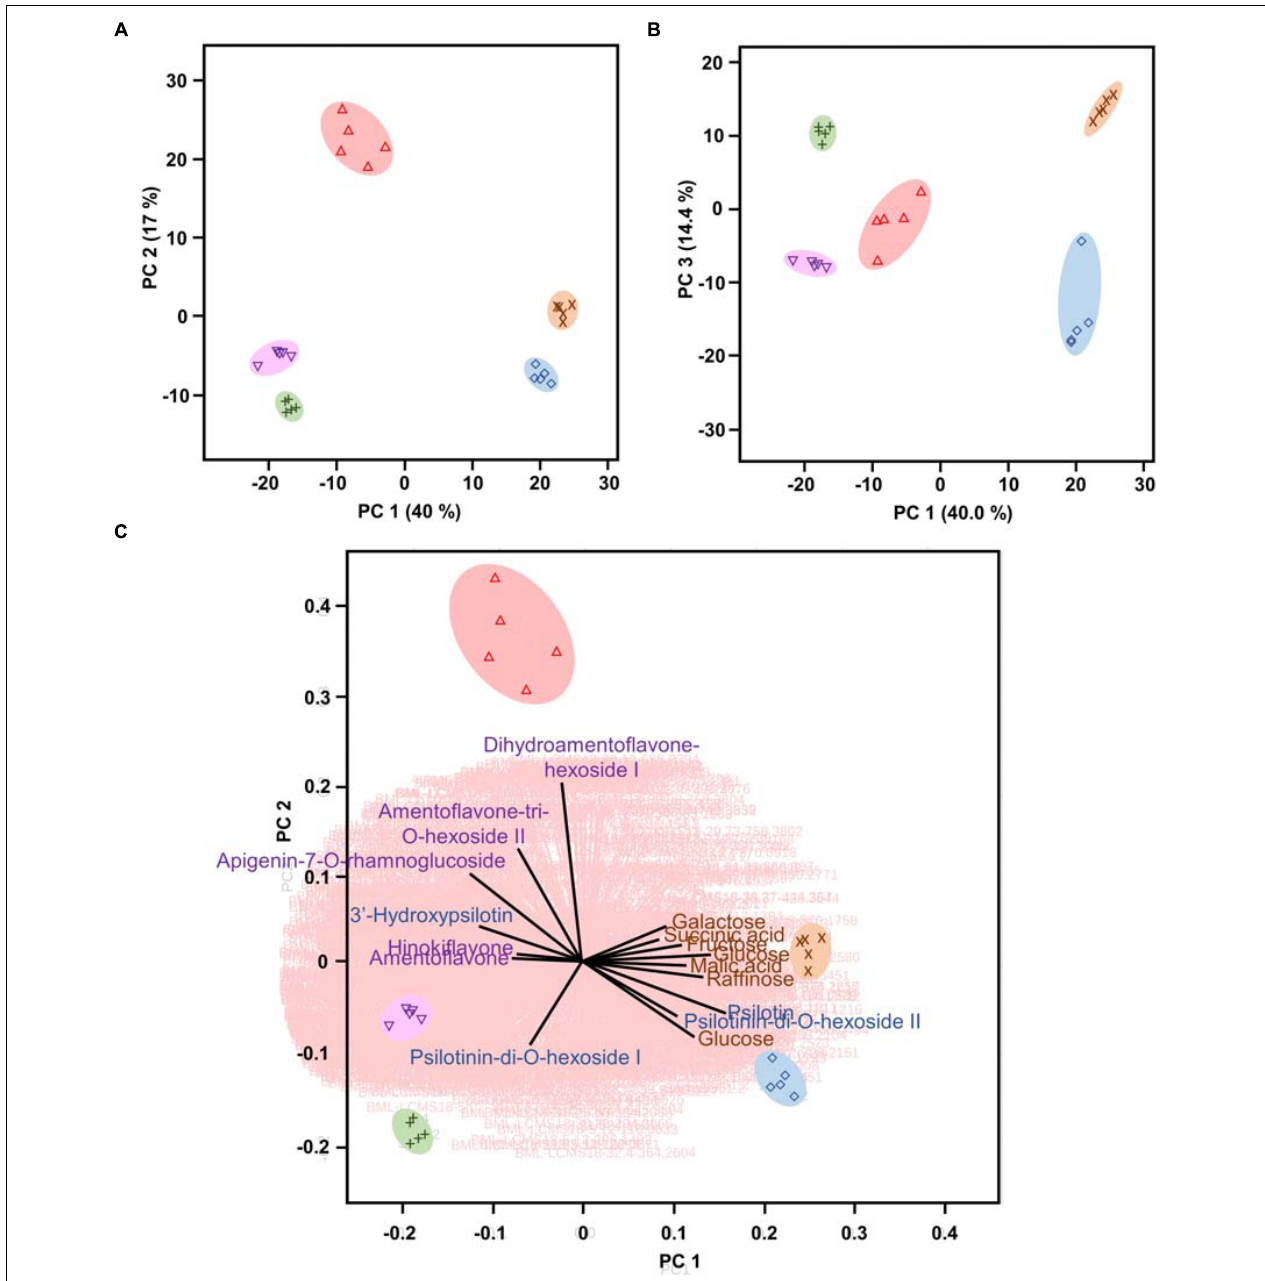
FIGURE 3 | Psilotum nudum organs have a unique metabolic fingerprint, based on PCA of combined GC-MS and HPLC-QTOF-MS data. (A) PCA plot for PC1 and PC2. (B) PCA plot for PC1 and PC3. (C) Bi-plot with selected component loadings (metabolites) highlighted (the vectors of the remaining AMT tags are shown with red lines in the background). The full component loadings are provided in Supplementary Table S3 . Symbols: rhizome (below-ground), purple cross; rhizome (above-ground), blue diamond; green synangium, green plus sign; yellow synangium, pink inverted triangle; brown synangium, red